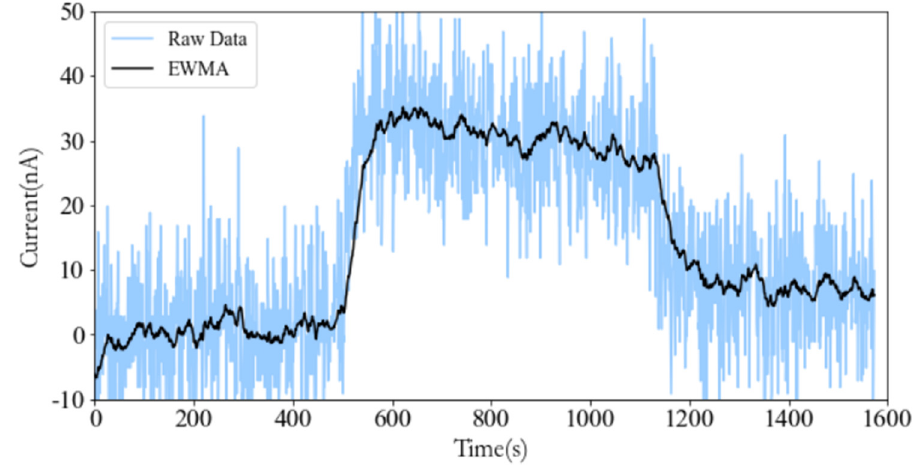
Figure 17. Comparison of before and after EWMA filtering.